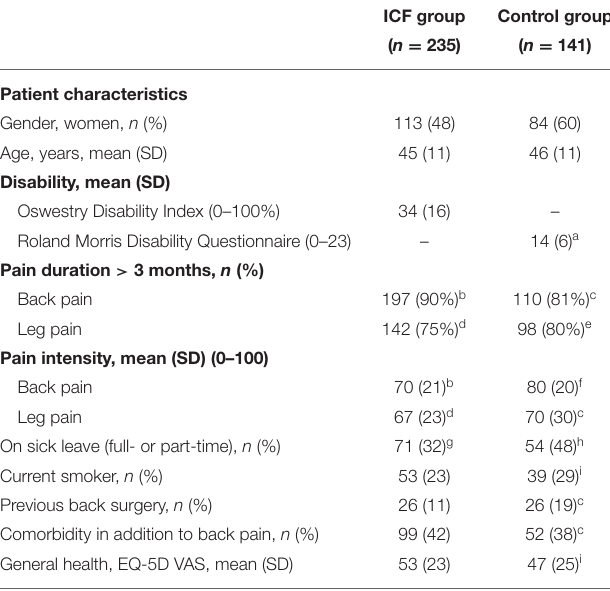
TABLE 4 | Demographics and clinical characteristics of study participants. ICF group Control group